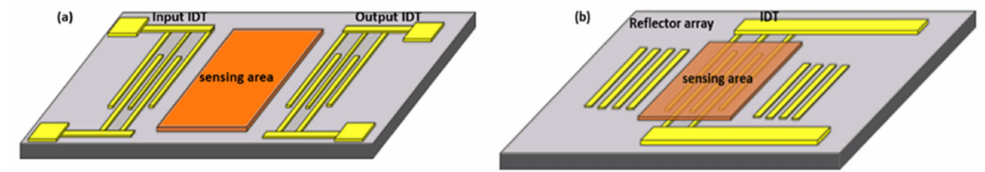
Figure 3. The schematic diagram and the design parameters of ( a ) an SDL and ( b ) one port